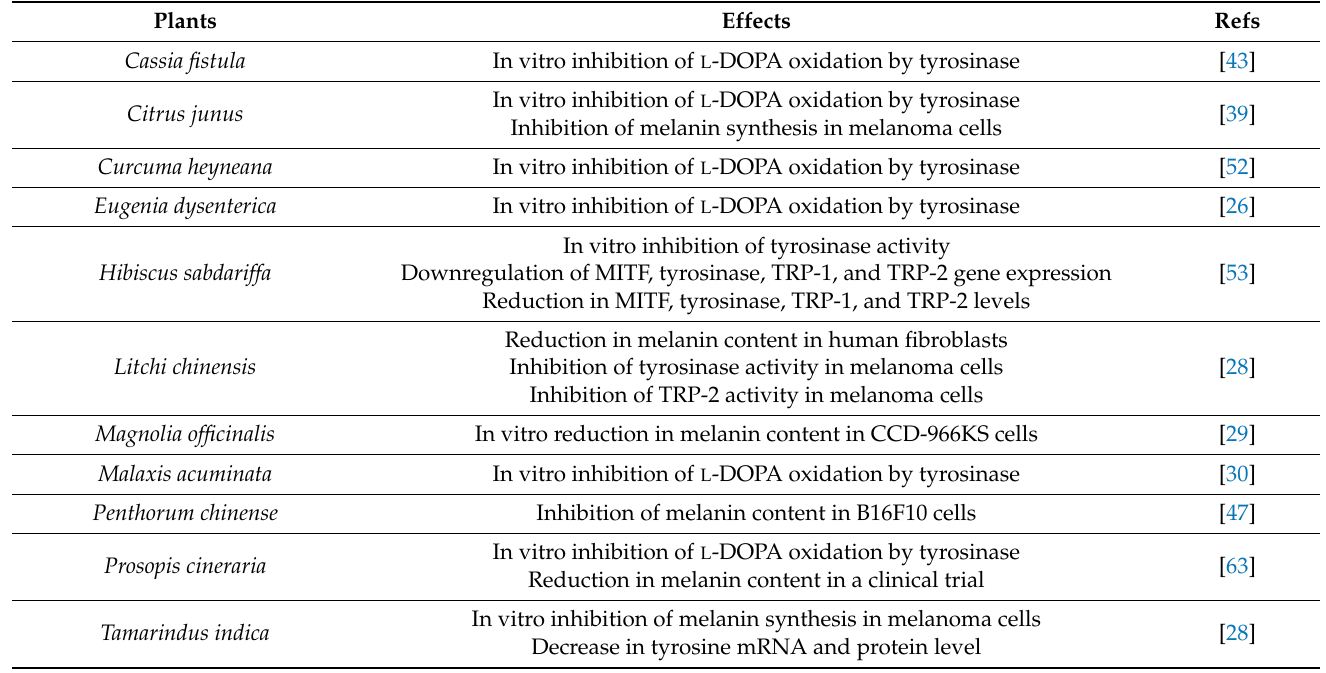
Table 3. Main plant herbal products with anti-aging effects acting on skin